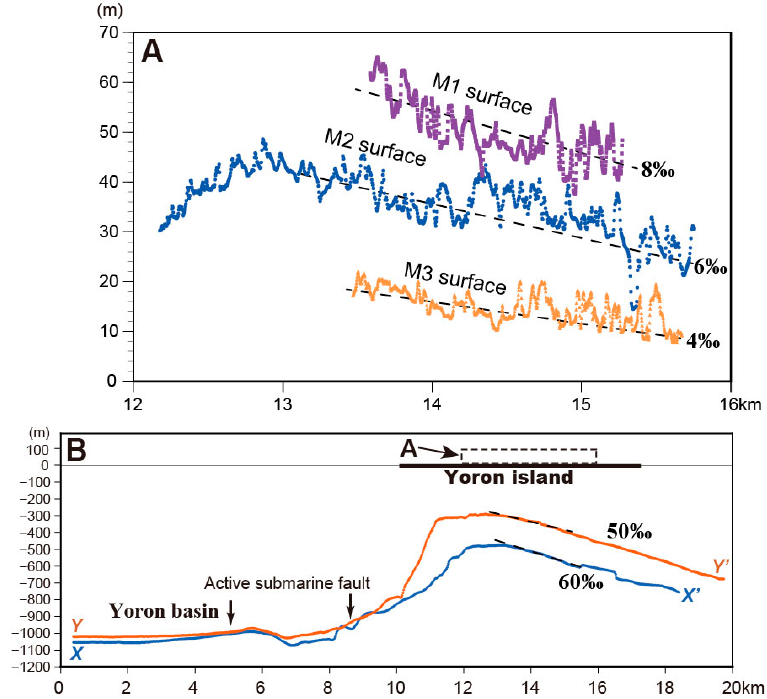
Figure 5. ( A ) Topographical profiles of the uplifted coral reef crests at the Yoron island, based on the DSM. ( B ) Topographical profiles across the Yoron basin and island shelf based on the DEM data